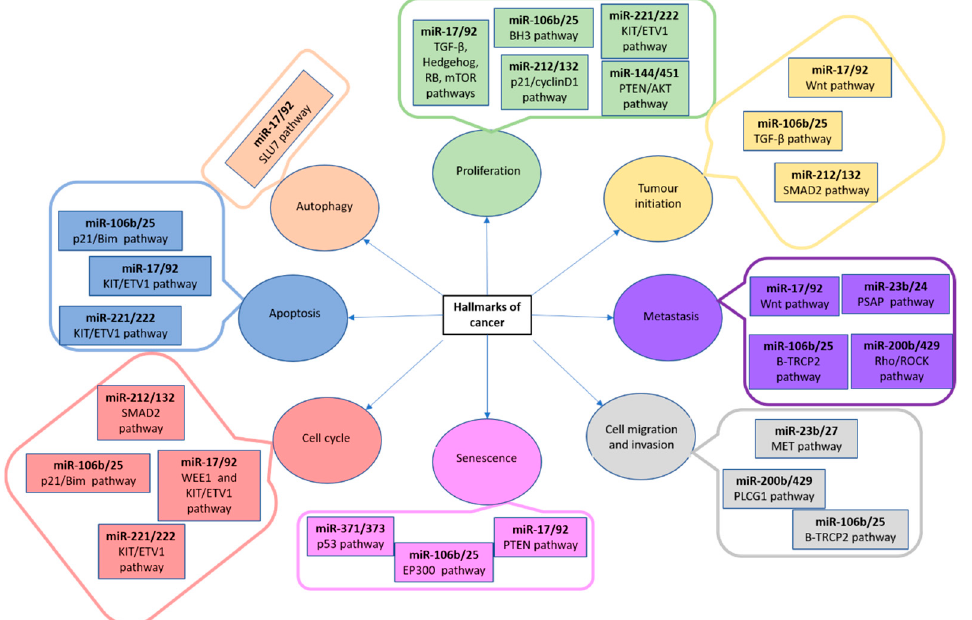
Figure 6. MiRNA clusters, their pathways and associated with cancer hallmarks. AKT: AKT ser- ine/threonine kinase; BH3: Bcl-2 homology 3 domain; BIM: Bcl-2-like protein 11; EP300: E1A- asosciated protein p300; ETV1: Ets variant gene 1; KIT: proto-oncogene tyrosine-protein kinase; MET: MET proto-oncogene receptor tyrosine kinase; mTOR: mammalian target of rapamycin complex 1; p21: cyclin-dependent kinase inhibitor 1A; PLCG1: phospholipase c gamma 1; PSAP: prosaposin; p53: tumour protein p53; PTEN: phosphatase and tensin homolog; RB1: RB transcriptional corepressor 1; RHO: ROCK Rho-associated protein kinase; SLU7: pre-mRNA splicing factor SLU7; SMAD2: mothers against dpp homolog 2; TRCP2: F-box and WD repeat domain containing 11; TGF: transforming growth factor; WEE1: Wee1A kinase; Wnt: wingless-type mmtv integration site family [57].